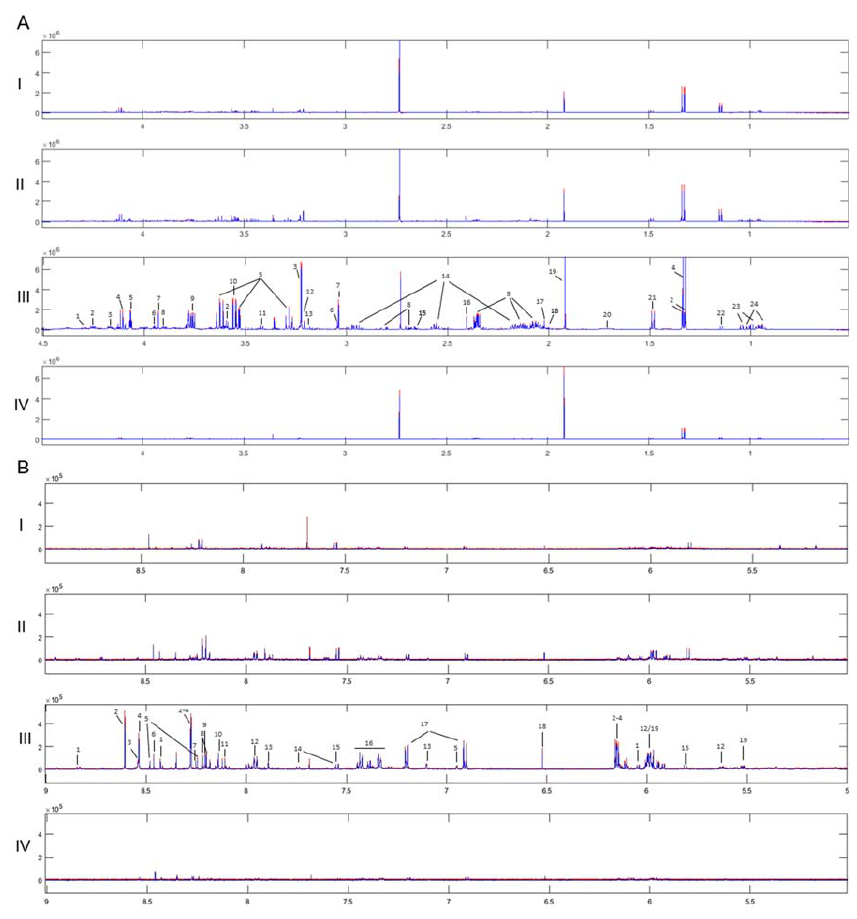
Figure 1. Average 1 H NMR spectra of the four groups and their standard deviation, where very low within-group variability is observed. Annotation is shown on the most abundant spectrum of the grade III group. (I. Grade I, II. Grade II, III. Grade III, IV. Grade IV). Red Line: Average + standard deviation, Blue Line: Average–standard deviation. ( A ) Aliphatic region: 1. UDPs, 2. Threonine, 3. Choline phosphate, 4. Lactate, 5. Myo-inositol, 6. Creatine phosphate, 7. Creatine, 8. Aspartate, 9. Glutamate, 10. Glycine, 11. Taurine, 12. Choline, 13. β -Alanine, 14. Glutathione, 15. Malate, 16. Succinate, 17. N-Acetylglutamine, 18. Proline, 19. Acetate, 20. Leucine, 21. Alanine, 22. Propylene glycol, 23. Valine, 24. Isoleucine. ( B ) Aromatic region: 1. NAD + , 2. AMP, 3. ATP, 4. ADP, 5. NADH,